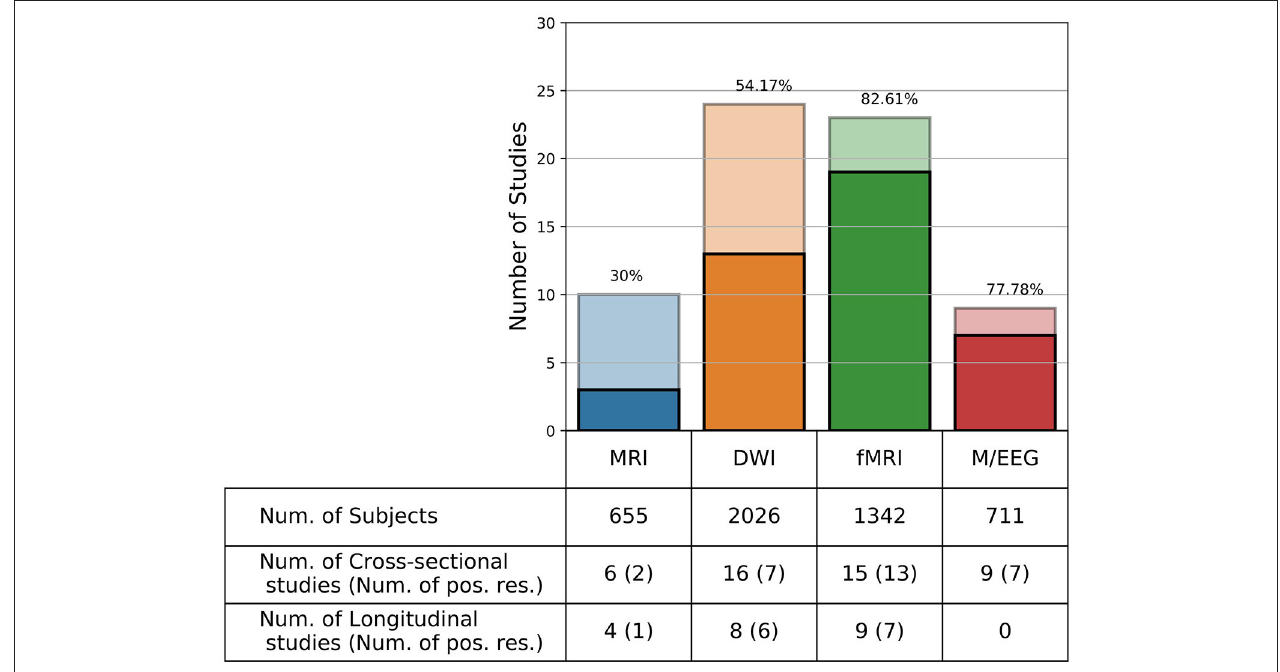
FIGURE 2 | Number of studies per imaging technique. Number of studies (Y-axis) per imaging technique (X-axis). Functional MRI has the highest number of experiments with positive results (i.e., studies which found an association between neuroimaging features and post-concussive symptoms). Darker colors show the number of studies with positive results, while lighter colors show the studies without significant findings. The number above each bar represent the percentage of studies with positive